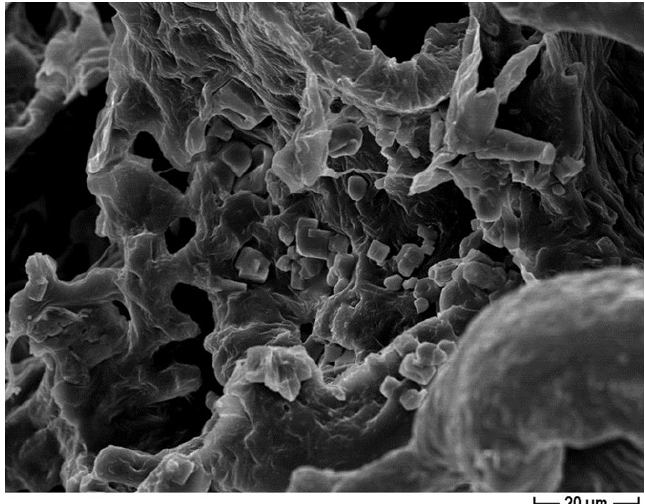
Figure 8. Representative FESEM micrographs of the 30% cinnamon oil-added PCL 3D scaffolds ob- tained by using NaCl salt as template, showing the integration of different Saos-2 cells at 1000× magnification, after 12 days of incubation.